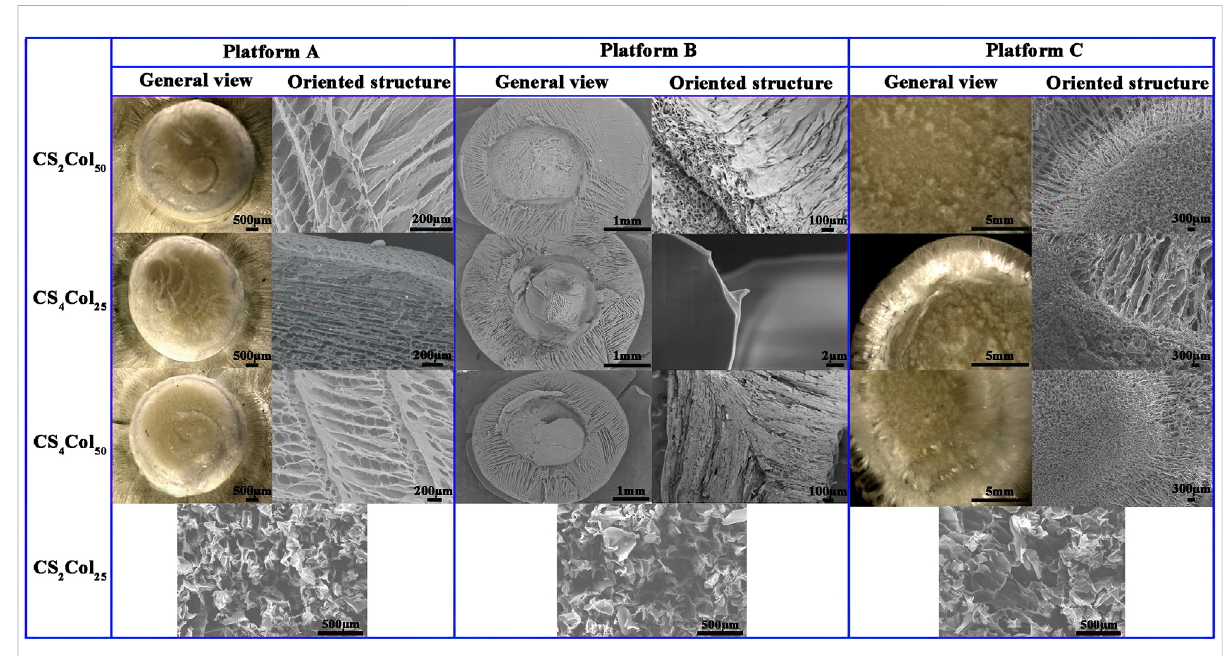
FIGURE 2 Morphologies of the CSCol scaffolds fabricated by different types of the platforms. (Changed the picture of CCS4Col25, oriented structure of platform A, and general view and oriented structure of platform C; added the picture of ACS2Col25, BCS2Col25, and